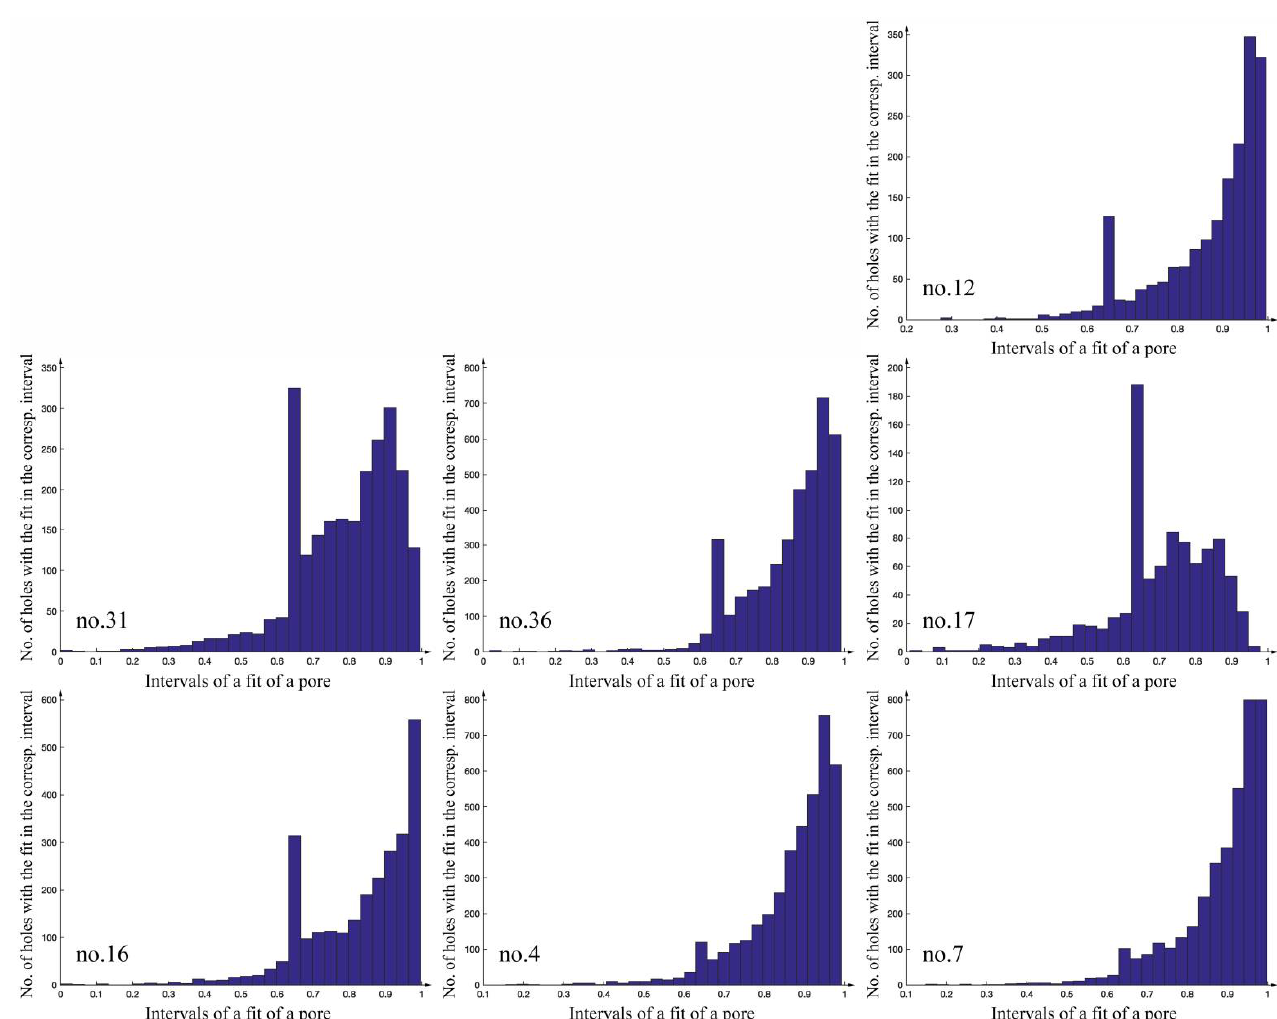
Figure 8. Statistical distribution of fitting values: relative frequencies of the ratio between the segmented volume and the volume of the corresponding fitted ellipsoid.